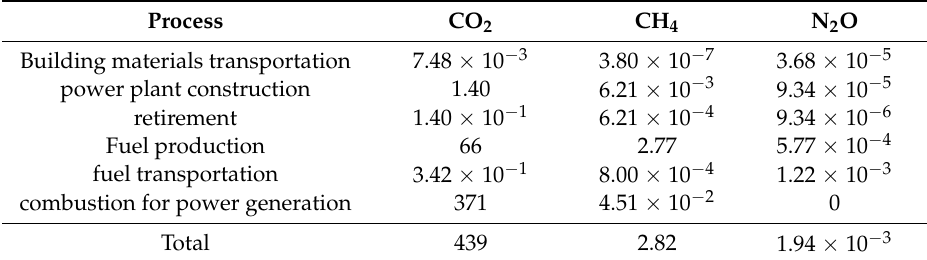
Table A2. Lifecycle GHG emissions of combined cycle natural gas fired generation (g CO 2 eq/KWh).